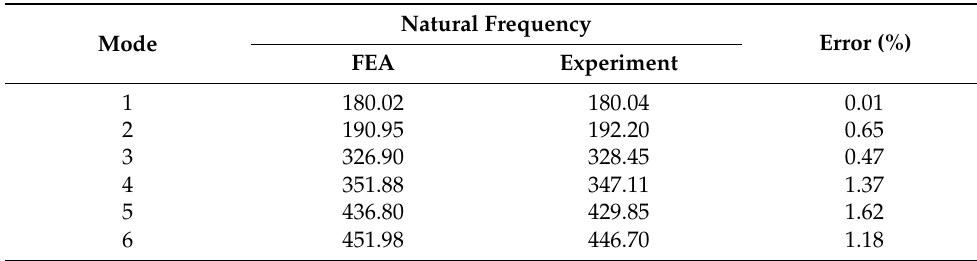
Table 9. Comparison of natural frequencies between modal analysis using finite elements and